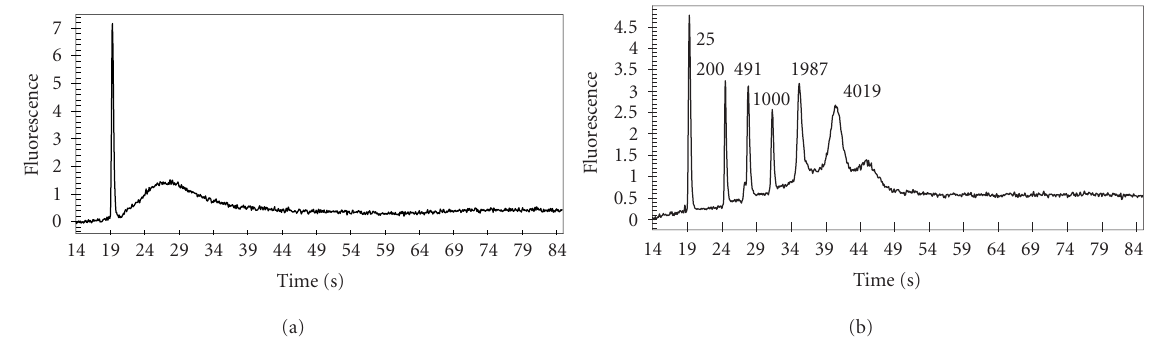
Figure 4. Fragment size profile of amplified RNA that was extracted from FACS-isolated EGFP-labeled cranial NCC as determined by electrophoretic separation on an Agilent RNA Biochip. Antisense RNA abundance (fluorescence) is graphed as a function of RNA fragment size (time of electrophoretic migration, in seconds). The graph (a) represents the fragment size profile from amplified, antisense RNA from FACS-isolated EGFP-labeled NCC while the graph (b) represents the fragment size profile of RNA size markers used as a standard. RNA fragment size (in nucleotides) is denoted adjacent to peaks on the profiles. The mRNA profile from the FACS-isolated NCC demonstrates a significant population of fragments in the 200–2000 nucleotide size range.